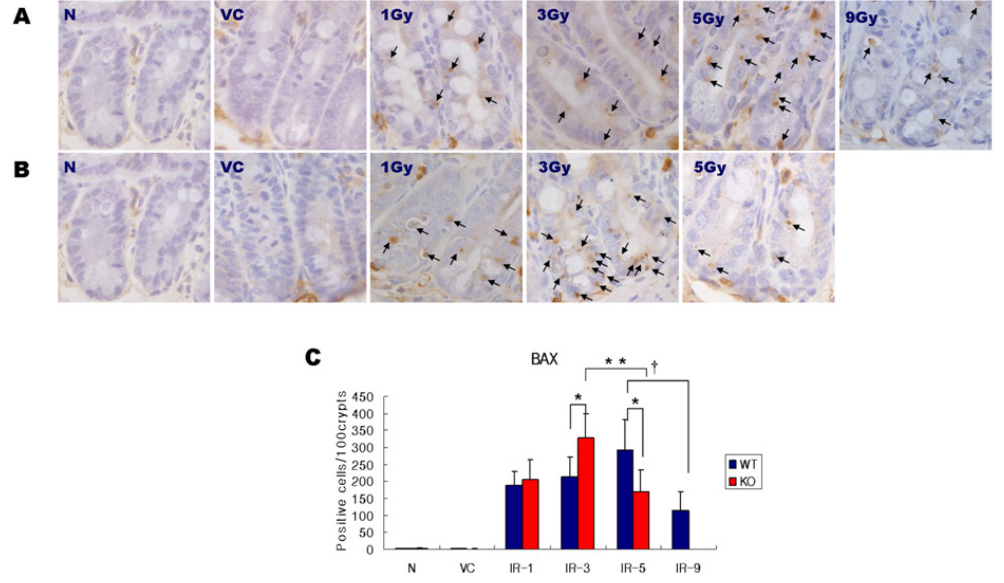
magnification × 1000, Bars = 20 μ m. ( B ) BAX expression detected by immunohistochemistry in the crypts of the intestine in SMP30 KO mice. N,